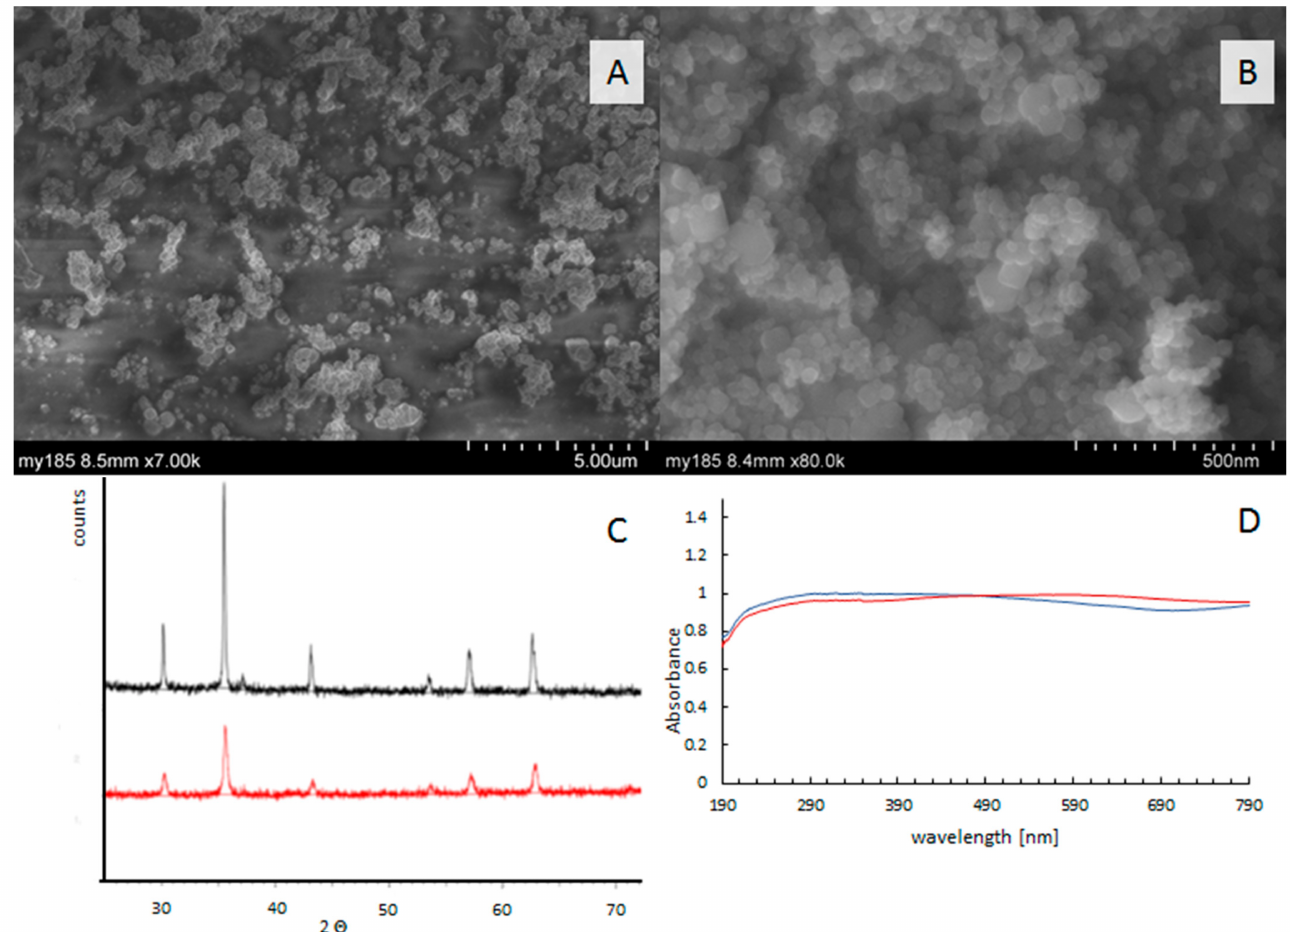
Figure 1. The catalysts’ characterization. SEM images of Fe 3 O 4 micro-size ( A ) and nano-size ( B ). X- ray diffraction measurements of µ -Fe 3 O 4 (black), n-Fe 3 O 4 (red) and ( C ), UV − VIS absorption spectra of µ -Fe 3 O 4 (red) and n-Fe 3 O 4 (blue) ( D ).